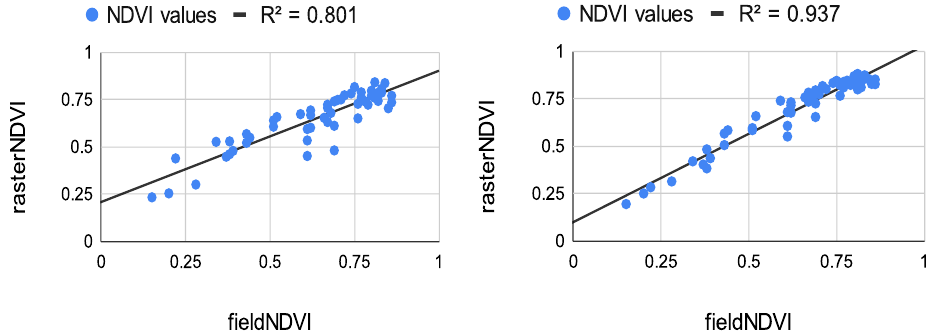
Figure 11. Left : Correlation between in situ measurements and raster values from the Sequoia sensor, flight time at 5:40 a.m. Right : Correlation between in situ measurements and raster values from the multiSPEC 4c sensor, flight time at 6:06 a.m.